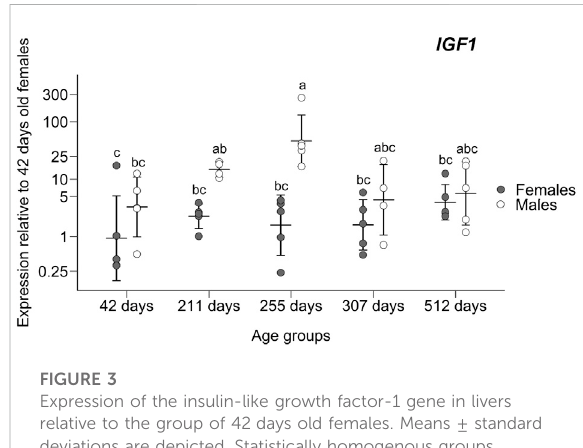
FIGURE 3 Expression of the insulin-like growth factor-1 gene in livers relative to the group of 42 days old females. Means ± standard deviations are depicted. Statistically homogenous groups identi fi ed by the post hoc Tukey test are